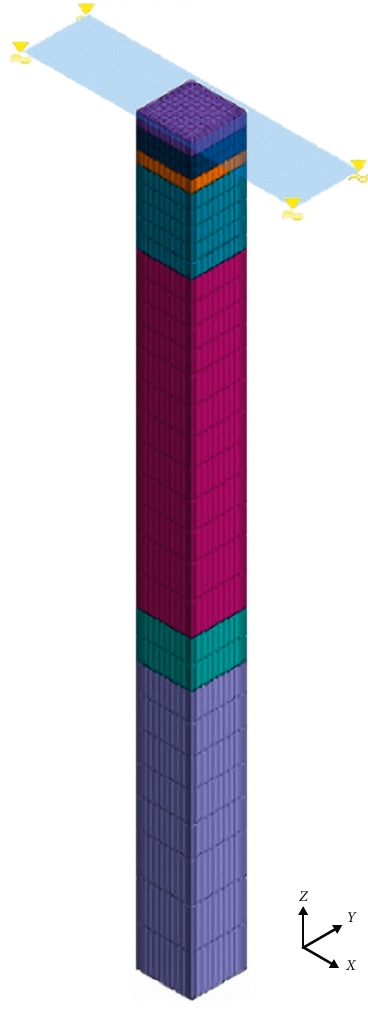
Figure 4: Consolidation analysis